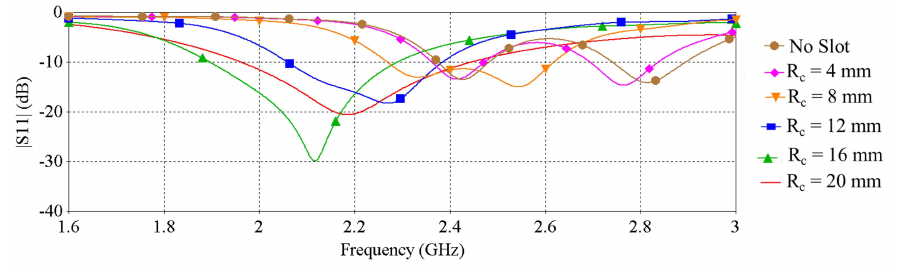
Figure 3. | S 11 | vs. frequency when varying the radius of the slot of the ground plane.